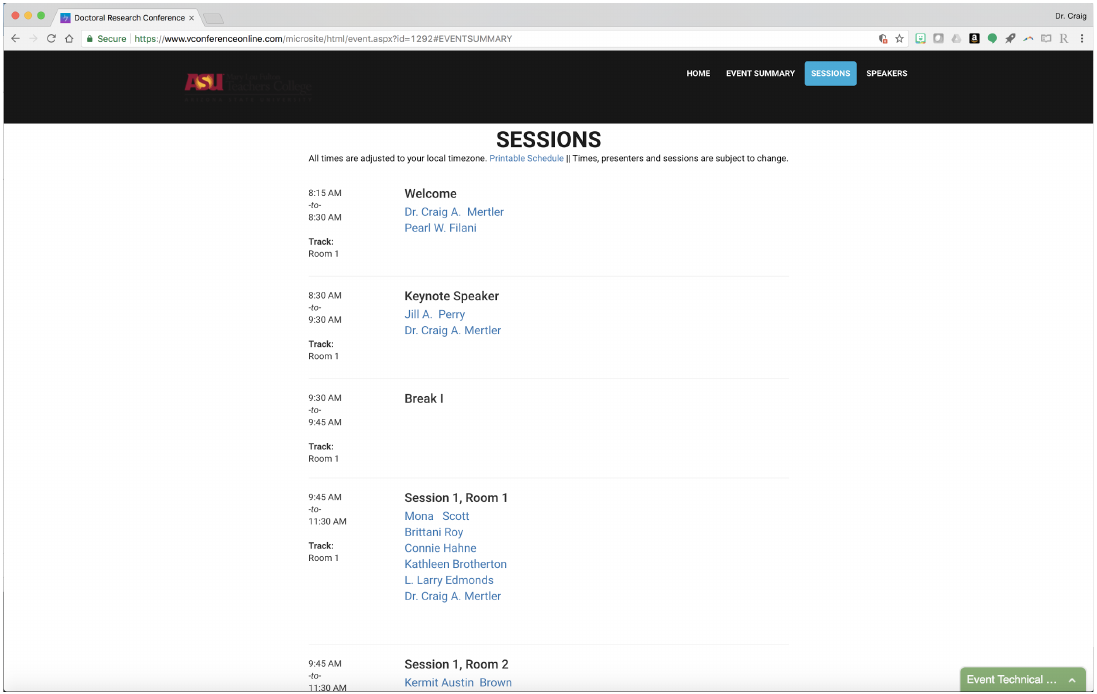
Realization and